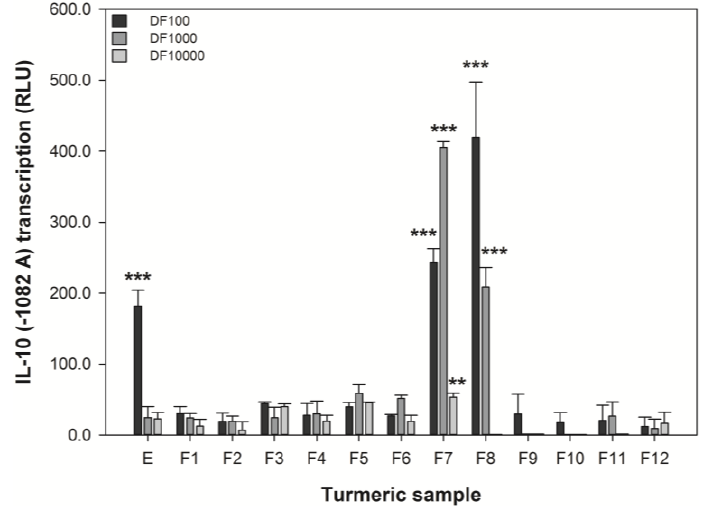
Figure 3. The effect of turmeric on the transcription of the IL-10 −1082 A variant. RLU refers to relative luminescence units and a positive value indicates an increase in promoter transcription. The data are expressed as the mean difference (±SEM) of three independent replicates compared to the untreated sample. A significant difference between untreated and treated cells indicated by ** p < 0.01, or *** p <